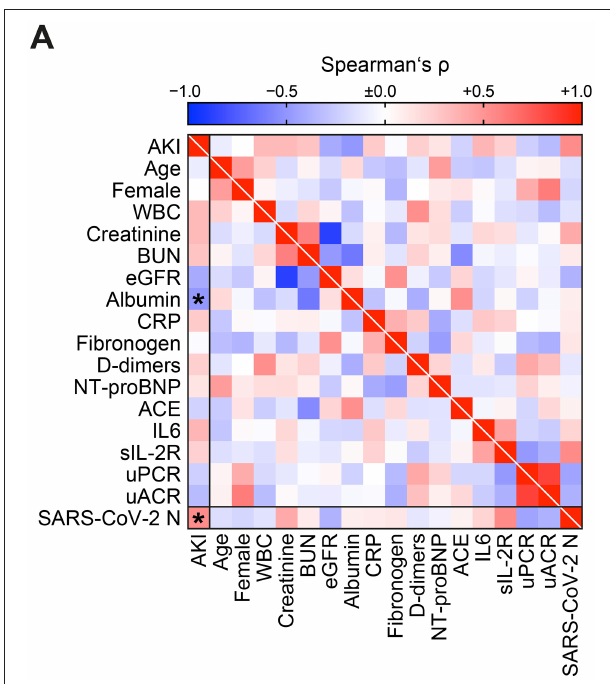
FIGURE 2 | Hypoalbuminemia at time of ICU admission identifies patients at risk for AKI. (A) Correlation between AKI, clinical, and routine laboratory parameters assessed at ICU admission is shown by heatmap reflecting the mean values of Spearman’s ρ ; asterisks indicate p < 0.05 . ACE, angiotensin converting enzyme; AKI, acute kidney injury; BUN, blood urea nitrogen; CRP, C-reactive protein; eGFR, estimated glomerular filtration rate (CKD-EPI); IL-6, interleukin-6; NT-proBNP, N-terminal pro-B-type natriuretic peptide; SARS-CoV-2N, severe acute respiratory syndrome coronavirus 2 nucleocapsid protein; sIL-2R, soluble interleukin-2 receptor; uACR, urinary albumin-to-creatinine ratio; uPCR, urinary protein-to-creatinine ratio; WBC, white blood cells.